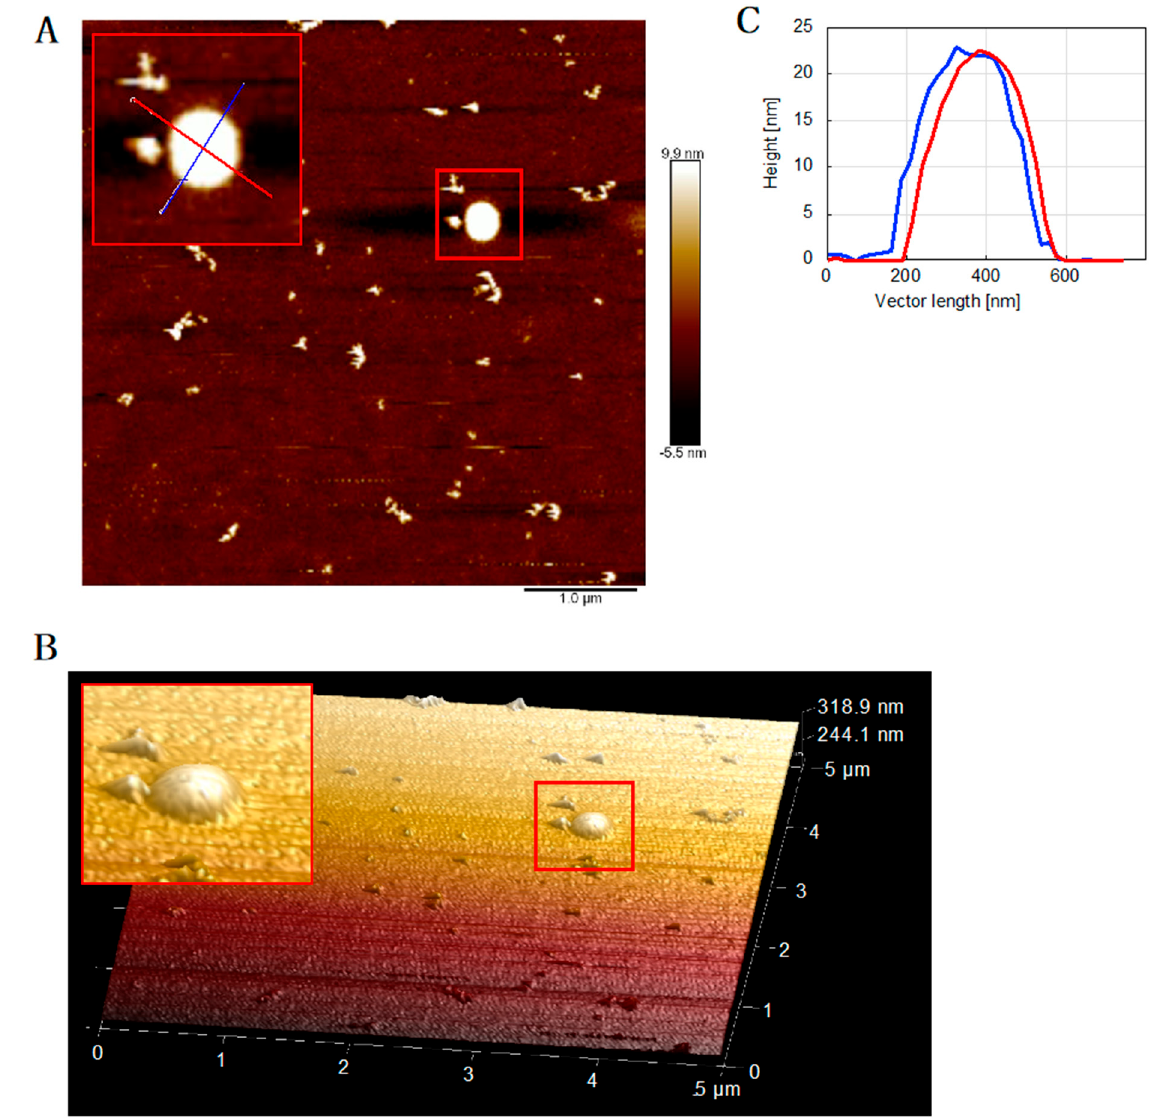
Figure 5. Formation of spherical complex “particulates” of Tau and PolDIP2. ( A ) AFM image of 15 µM Tau + 5 µM PolDIP2 at the 48-h reaction time (sample from the same reaction as in Figure 2A). ( B ) The 3D image was created based on the AFM image in Figure 5A. A spherical complex is highlighted with a red square. AFM cross sections are also inserted into Figure 5A shown by cross-sectional lines using the same color coding ( C ). Table 1. Statistical data of the fibril height distributions for the samples presented in Figure 4.